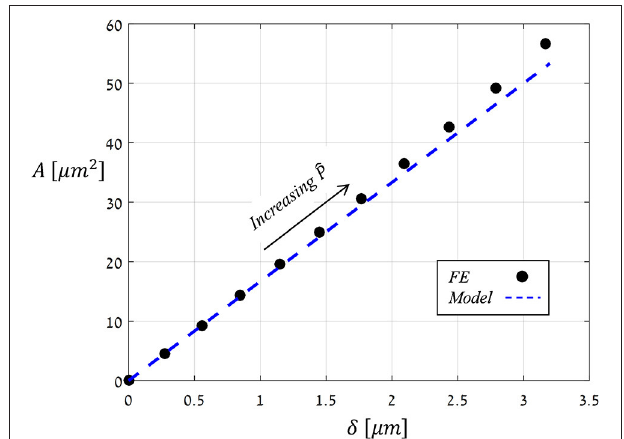
FIGURE 5 | Schematic illustration of a guard cell in its closed (blue) and open (red) states, shown with the corresponding displacement of the interior wall of the guard cell (as indicated in Figure 4 ). The localized displacement u ( x ) due u ( x 0 ), are indicated by the black arrows. to pore opening, and the aperture δ ≡